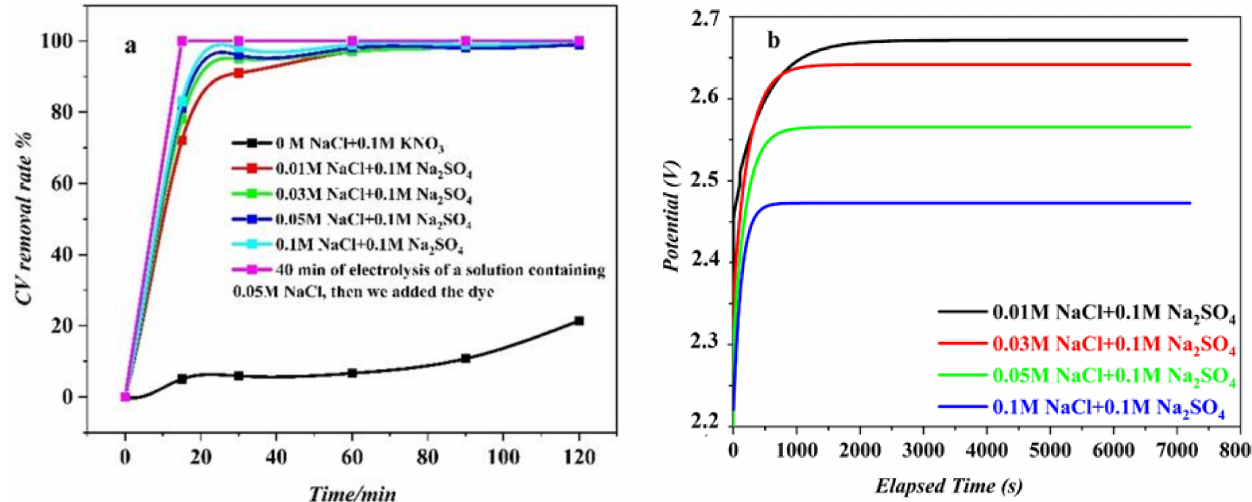
Figure 4. ( a ) Effect of NaCl concentration on degradation of the CV solution; ( b ) chronopotentiograms during electrolysis of the CV solution ([CV] 0 = 10 mg L − 1 , initial pH = 7, i = 50 mA cm − 2 and temperature = 25 ◦